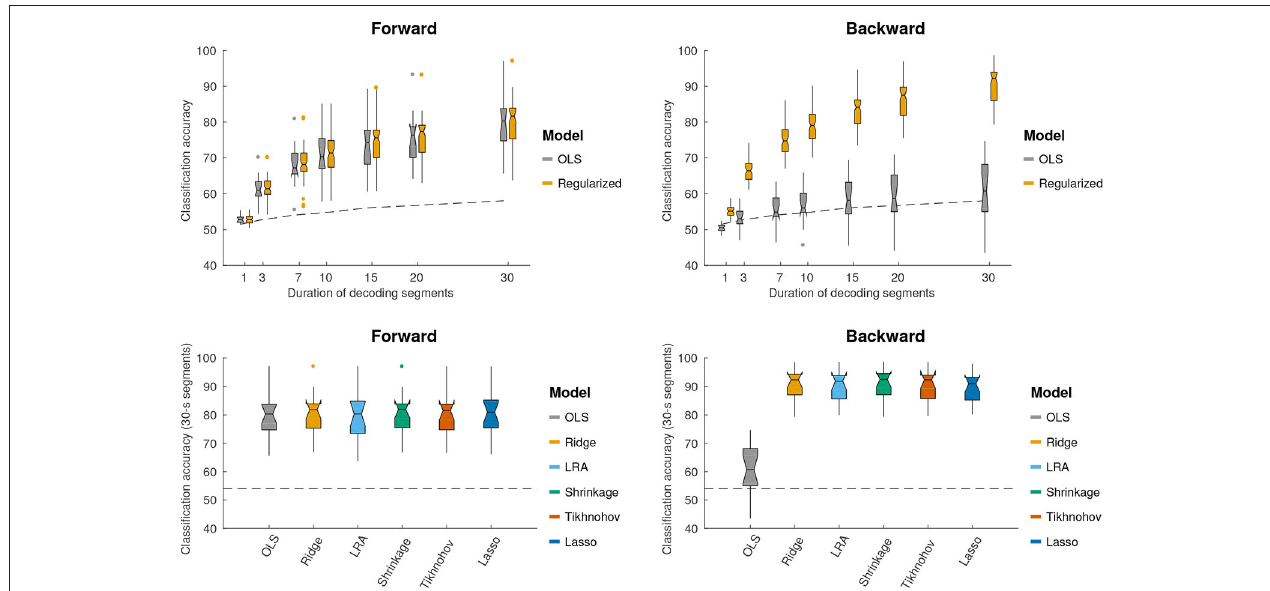
FIGURE 3 | Using different forward/backward models to decode selective auditory attention from multi-channel EEG data. Classification performance is shown for different decoding segment lengths (1, 3, 7, 10, 15, 20, 30 s). ( Top , left and right) Show the classification performance for forward and backward models respectively. Performance is shown for the OLS scheme and an average across regularized schemes. Regularized schemes were averaged to concisely illustrate the higher classification accuracy obtained by these schemes compared to OLS for the backward model, but not the forward model. ( Bottom , left and right) Show the classification performance for 30 s long decoding segments. The different regularization schemes are shown in different colors (see legend). Notched boxplots show median, and first and third quartiles. Whiskers show 1.5 × IQR. Dots indicate outliers. The dashed line shows the above-chance significance threshold at p =